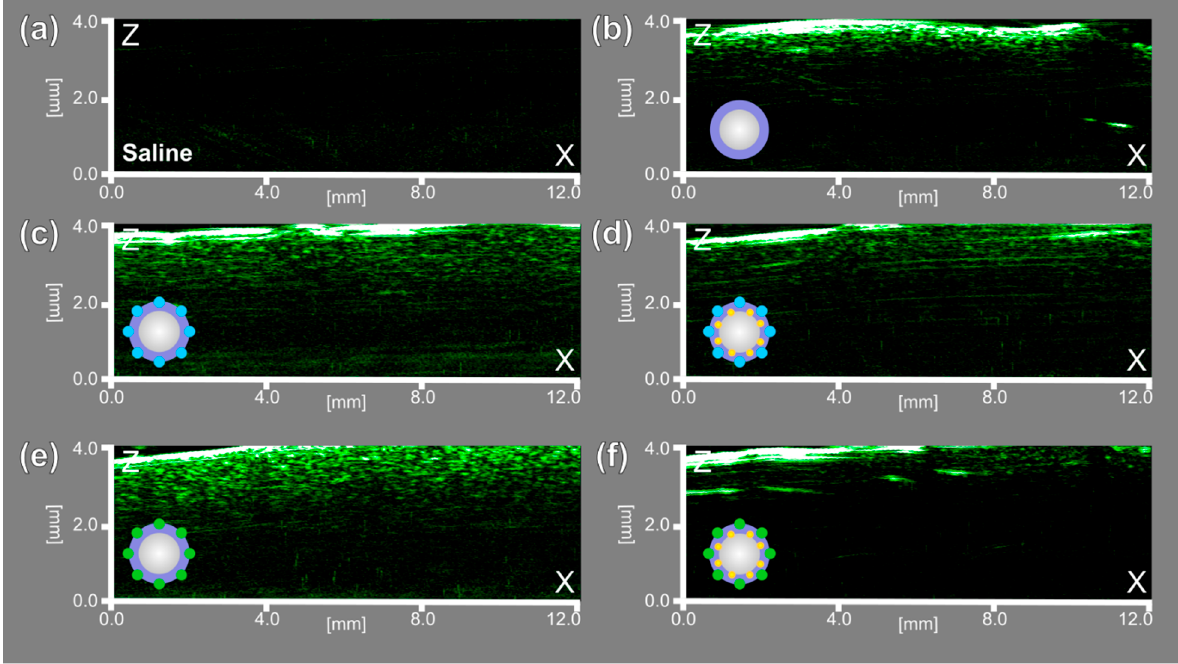
Figure 9. Ultrasound (US ) imaging at a frequency of 33 MHz for ( a ) saline solution, ( b ) BSA MBs, ( c ) BSA-ZnPc MBs, ( d ) BSA-ZnPc-AuNPs MBs, ( e ) BSA-ICG MBs, ( f ) BSA-ICG-AuNPs MBs.